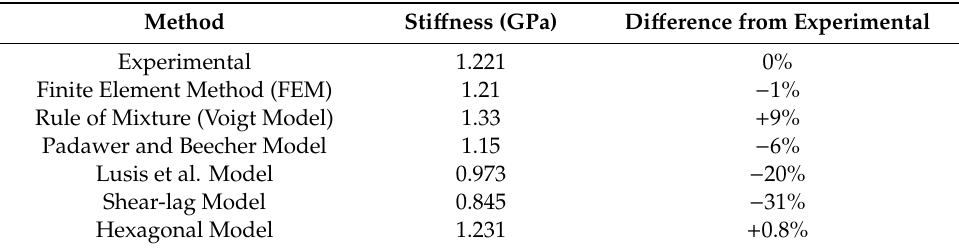
Table 5. Sti ff ness of PS-PU Hexagonal Nacre-like